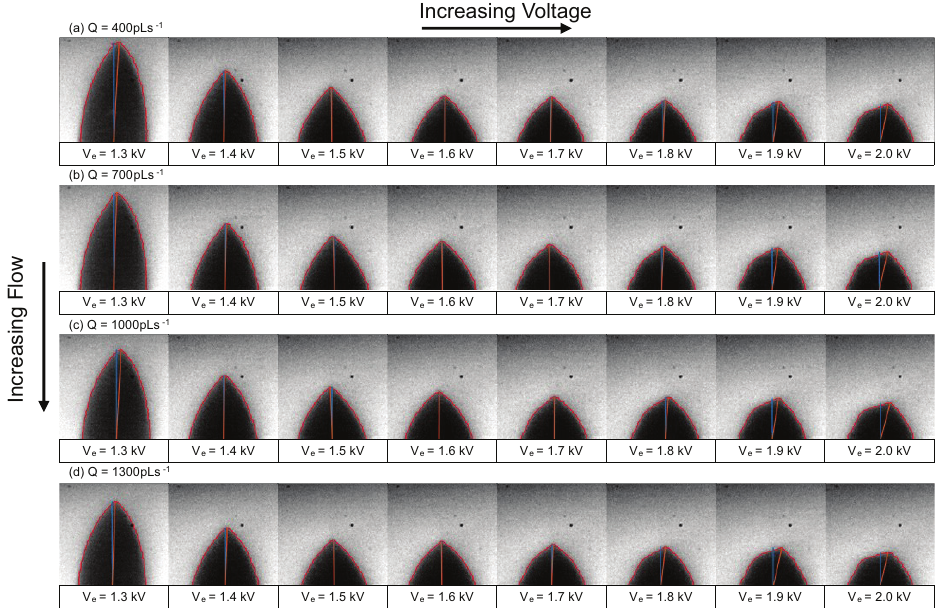
Figure 3. Images of the EMI-Im electrospray emission site with flow setpoints between 400pLs − 1 and 1300pLs − 1 , and emitter voltage setpoints from 1.3kV to 2.0kV. The blue line indicates the center axis of the capillary. The orange line indicates the angle of the cone’s apex with respect to the center axis. Image labels corresponding to the following flow rates: ( a ) 400pLs − 1 , ( b ) 700pLs − 1 , ( c ) 1000pLs − 1 , and ( d ) 1300pLs − 1 . Figure modified from Ref. [43]